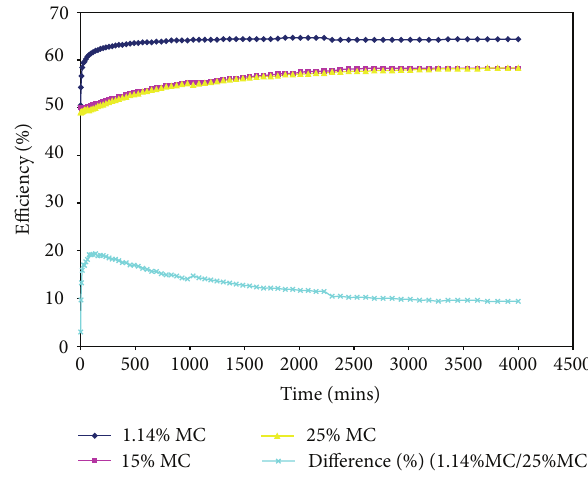
Figure 3: Simulated impact of moisture content on conversion effi-